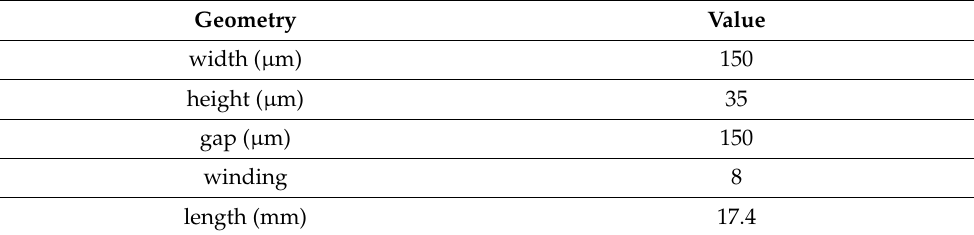
Table 2. Micro-coil geometry.